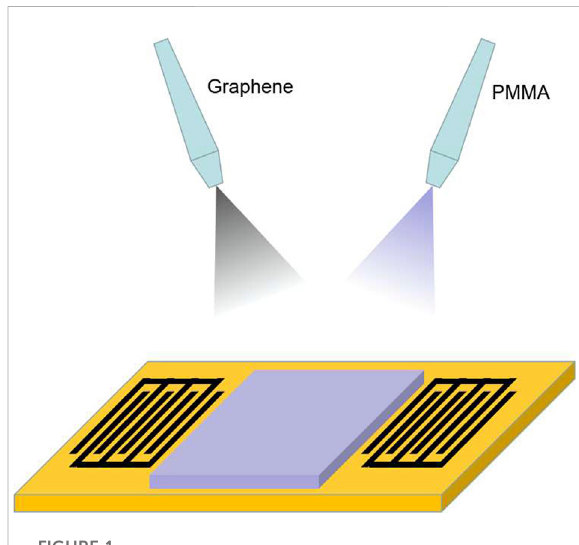
FIGURE 1 Schematic of the multi-source spray deposition